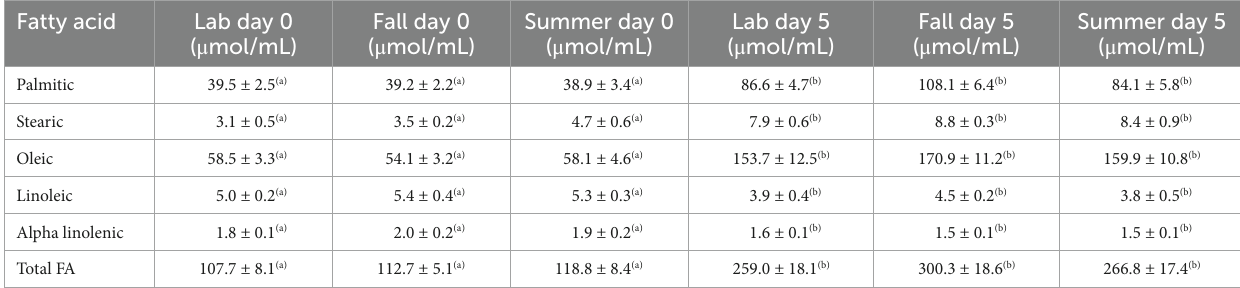
TABLE 1 Concentration of specific essential and non-essential fatty acids in the fat body of non-flown true armyworm adults as a function of age and rearing conditions.